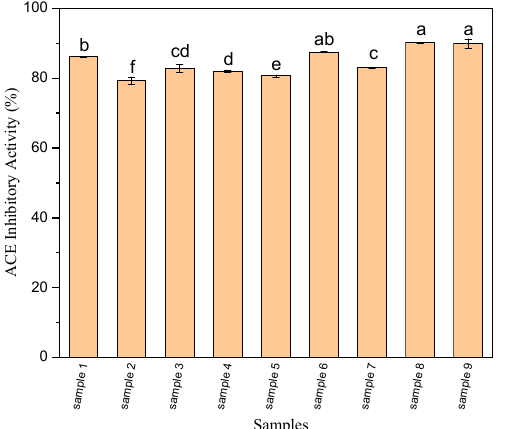
Figure 2. Angiotensin-converting enzyme (ACE) inhibitory activity (%) of OSPH produced under different conditions. Data are mean ± SD of three replications and the values with different letter are significantly different ( p < 0.05).